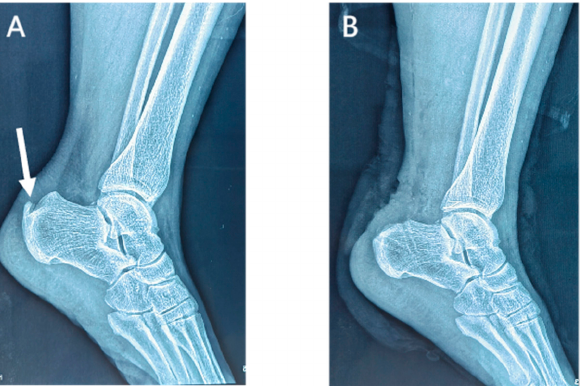
Figure 4. Preoperative ( A ) and postoperative ( B ) lateral radiographs of the ankle in the suture bridge group. Arrow, a calcific lesion in the Achilles tendon.